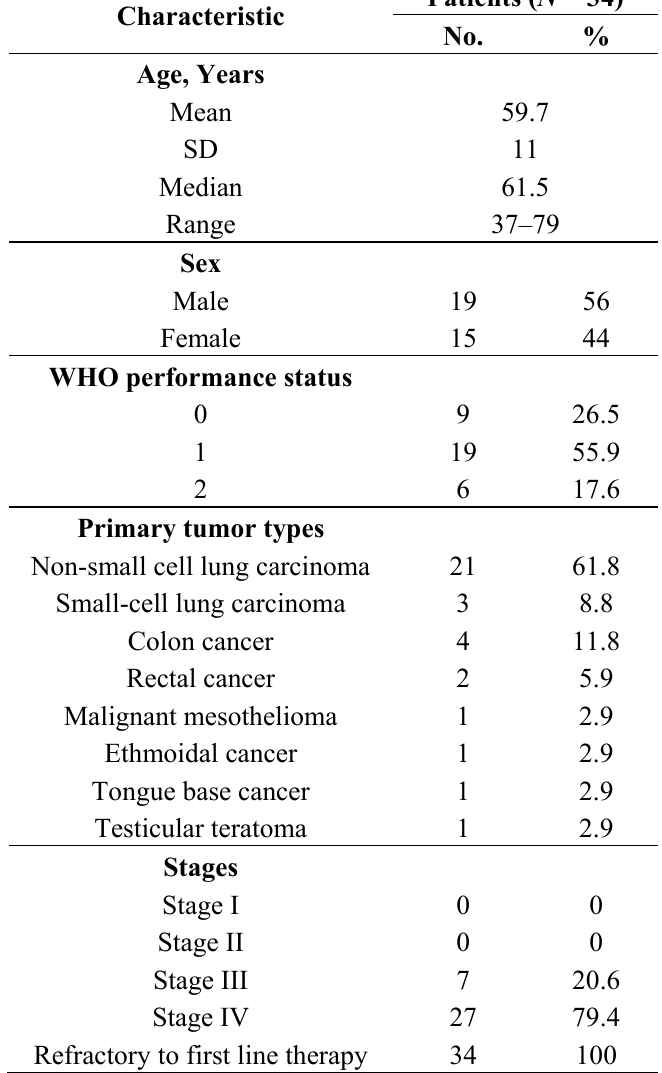
Table 2. Demographics and clinical characteristics of patients enrolled in SECAR trial. Patients ( N = Characteristic